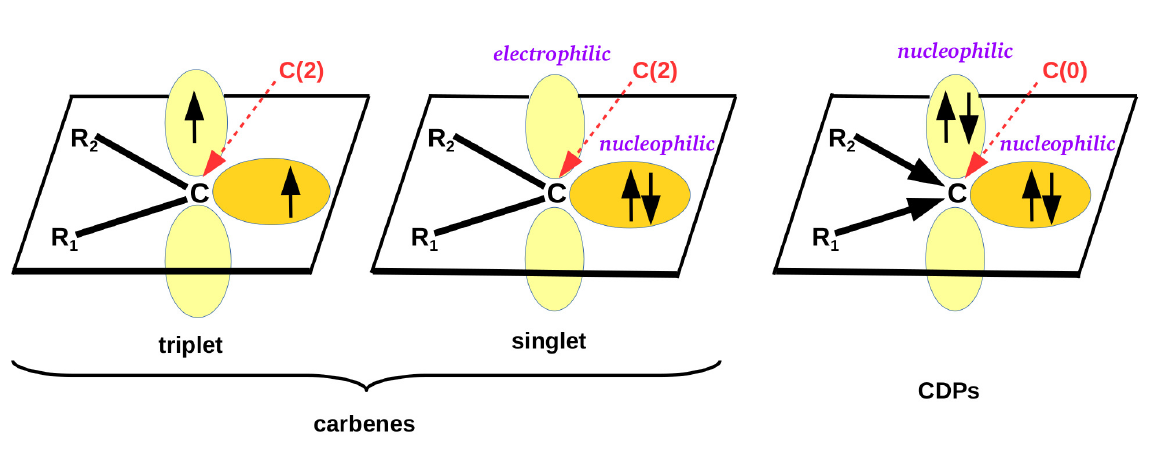
Figure 1. Electronic states of carbenes and